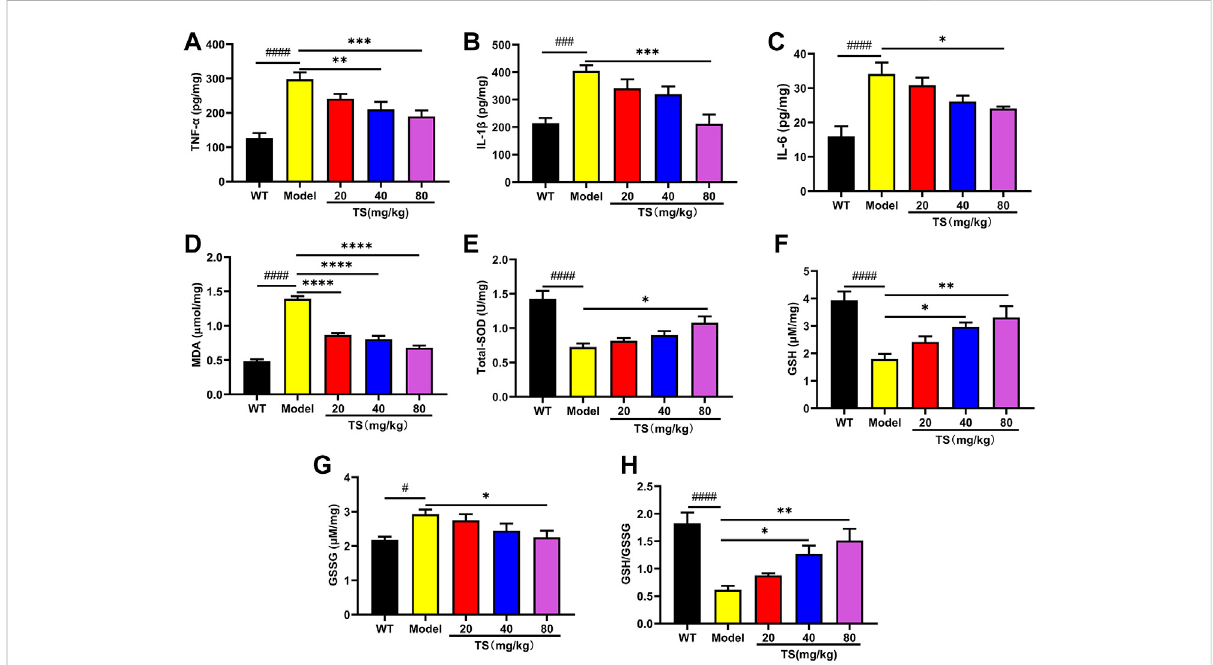
FIGURE 8 TStreatmentinhibitedcerebralin fl ammationandoxidativestressinAPP/PS1mice. (A) TheeffectofTSonthelevelsofTNF- α inthebrainofAPP/ PS1micewasmeasuredbyELISA( #### p < 0.0001,** p =0.0065,*** p =0.0008). (B) TheeffectofTSonthelevelsofIL-1 β inthebrainofAPP/PS1mice was measured by ELISA ( ### p 0.0002, *** p = 0.0002). (C) The effect of TS on the levels of IL-6 in the brain of APP/PS1 mice was measured by ELISA ( #### p < 0.0001, * p = 0.0209). (D) The effect of TS on the levels of MDA in the brain of APP/PS1 mice was measured by ELISA ( #### p < 0.0001, **** p < 0.0001). (E) The effect of TS on the levels of SOD in the brain of APP/PS1 mice was measured by ELISA ( #### p < 0.0001, * p = 0.0129). (F) The effectofTSonthelevelsofGSHinthebrainofAPP/PS1micewasmeasuredbyELISA( #### p < 0.0001,* p =0.0177,** p =0.0020). (G) TheeffectofTS on the levels of GSG in the brain of APP/PS1 mice was measured by ELISA ( # p = 0.0123, * p = 0.0248). (H) Quantitative analysis of the ratio of